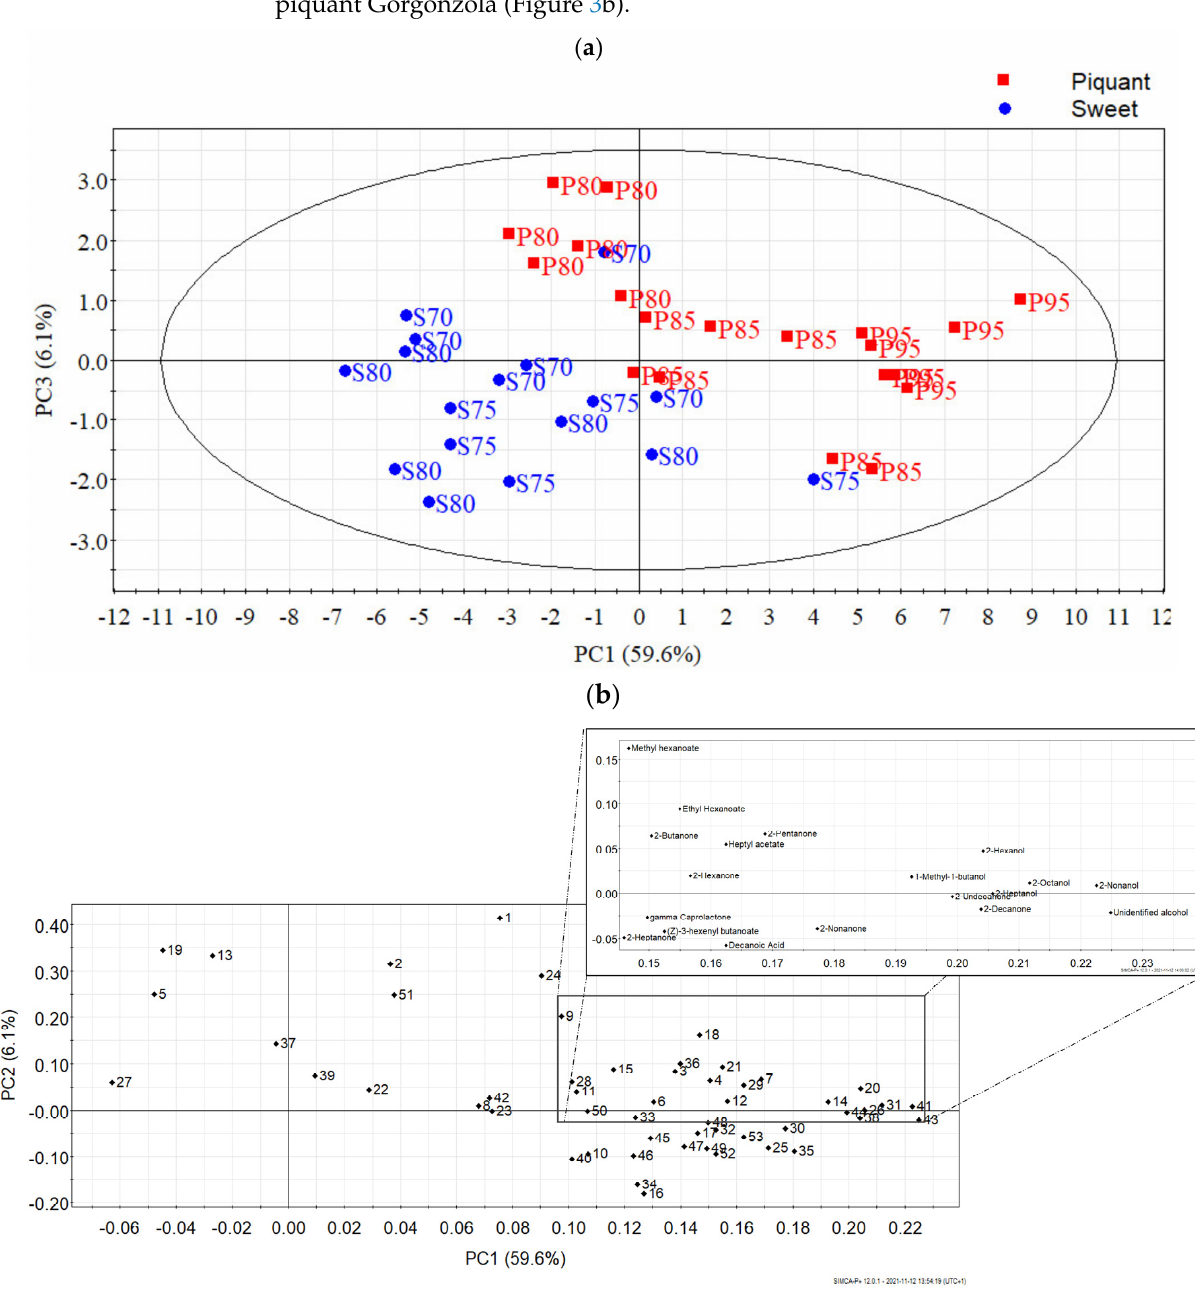
Figure 3. Scores ( a ) and loadings ( b ) plots of the 1st and 3rd principal components obtained from the PCA applied to VOCs